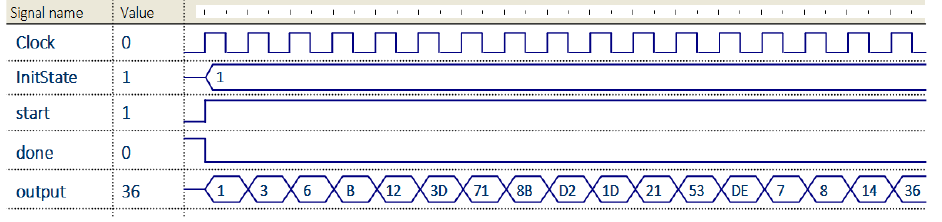
Figure 9. Output waveform for 8-bit 90/150 LHCA (decimal form).